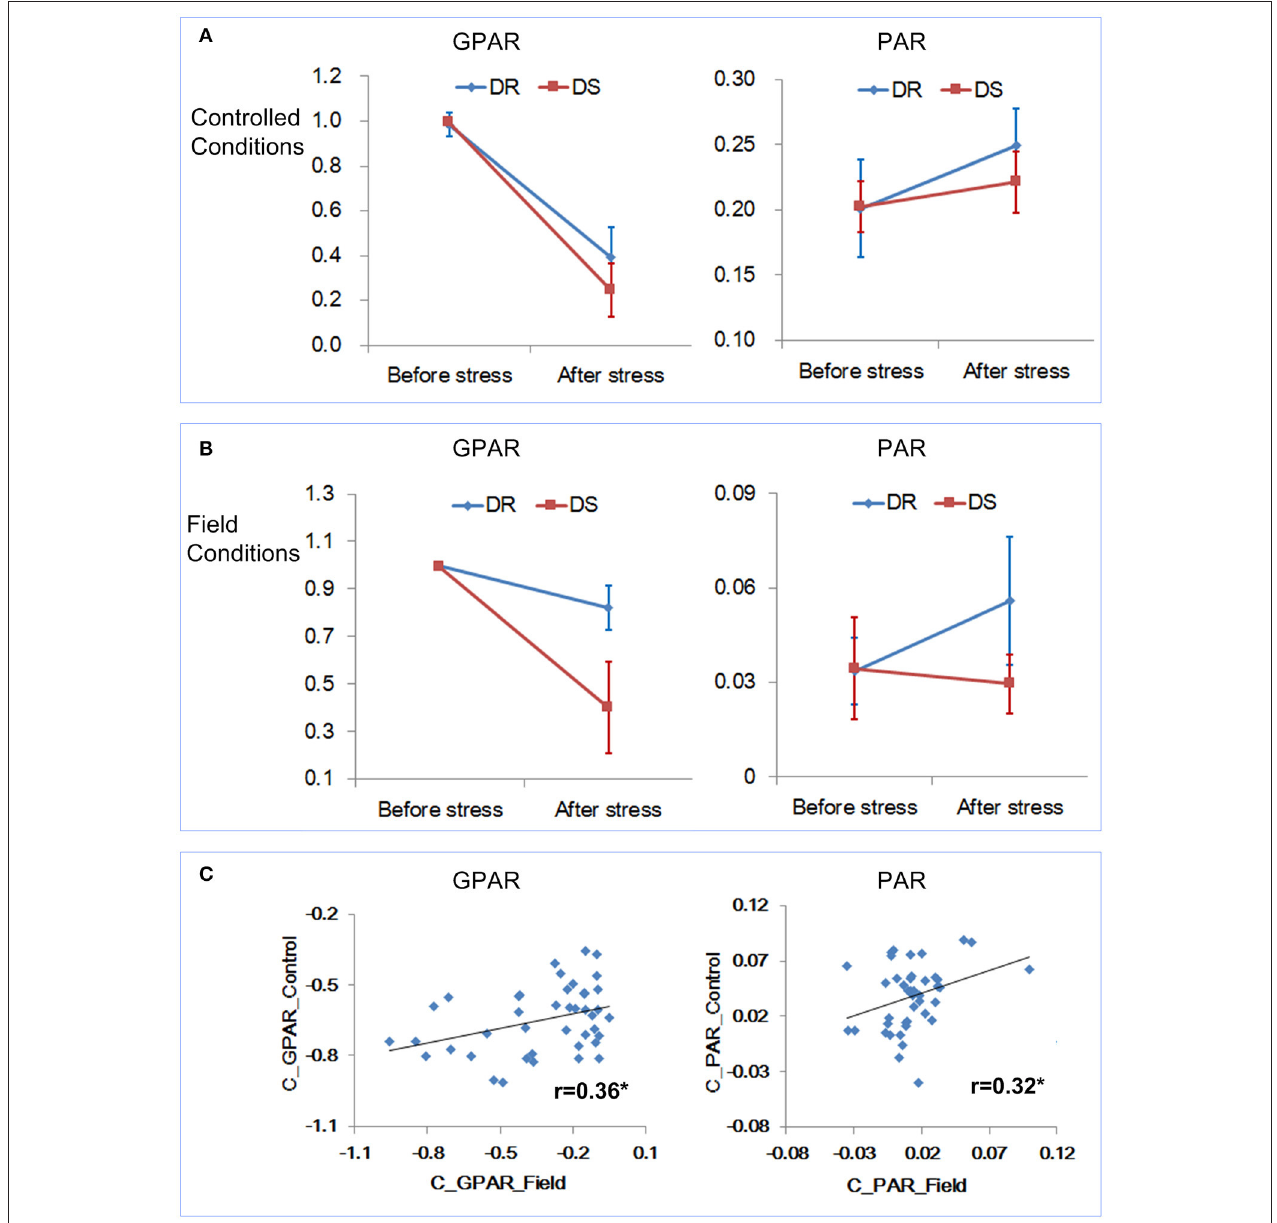
FIGURE 8 | Relevance of the drought-related features under controlled conditions and field conditions. (A) Dynamics of GPAR and PAR under controlled conditions. (B) Dynamics of GPAR and PAR under field conditions. The markers and the bars in each line represent the mean value and standard deviation across the accessions, respectively. (C) Scatter plot of feature change under controlled conditions vs. feature change under field